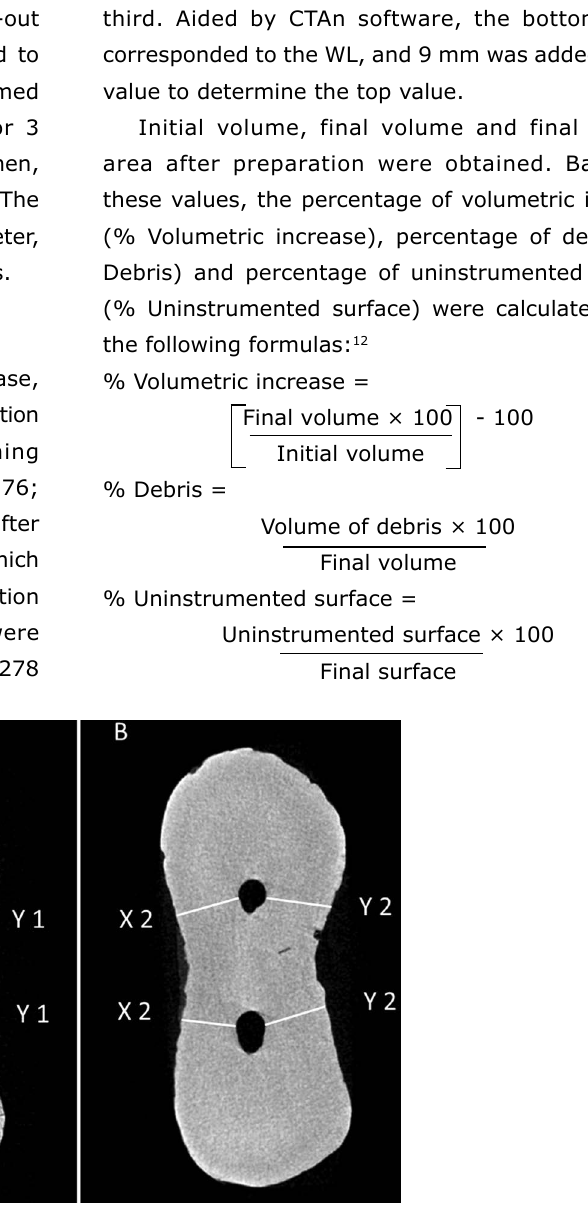
Figure 1- Representative micro-CT cross sections of the middle third of the PDL group, taken from the mesial root canals of mandibular molars, showing the shortest distance between the edge of the root and the canal, determined to perform the analyses of transportation and centralization in each group. A, preoperative root canal, and B, after